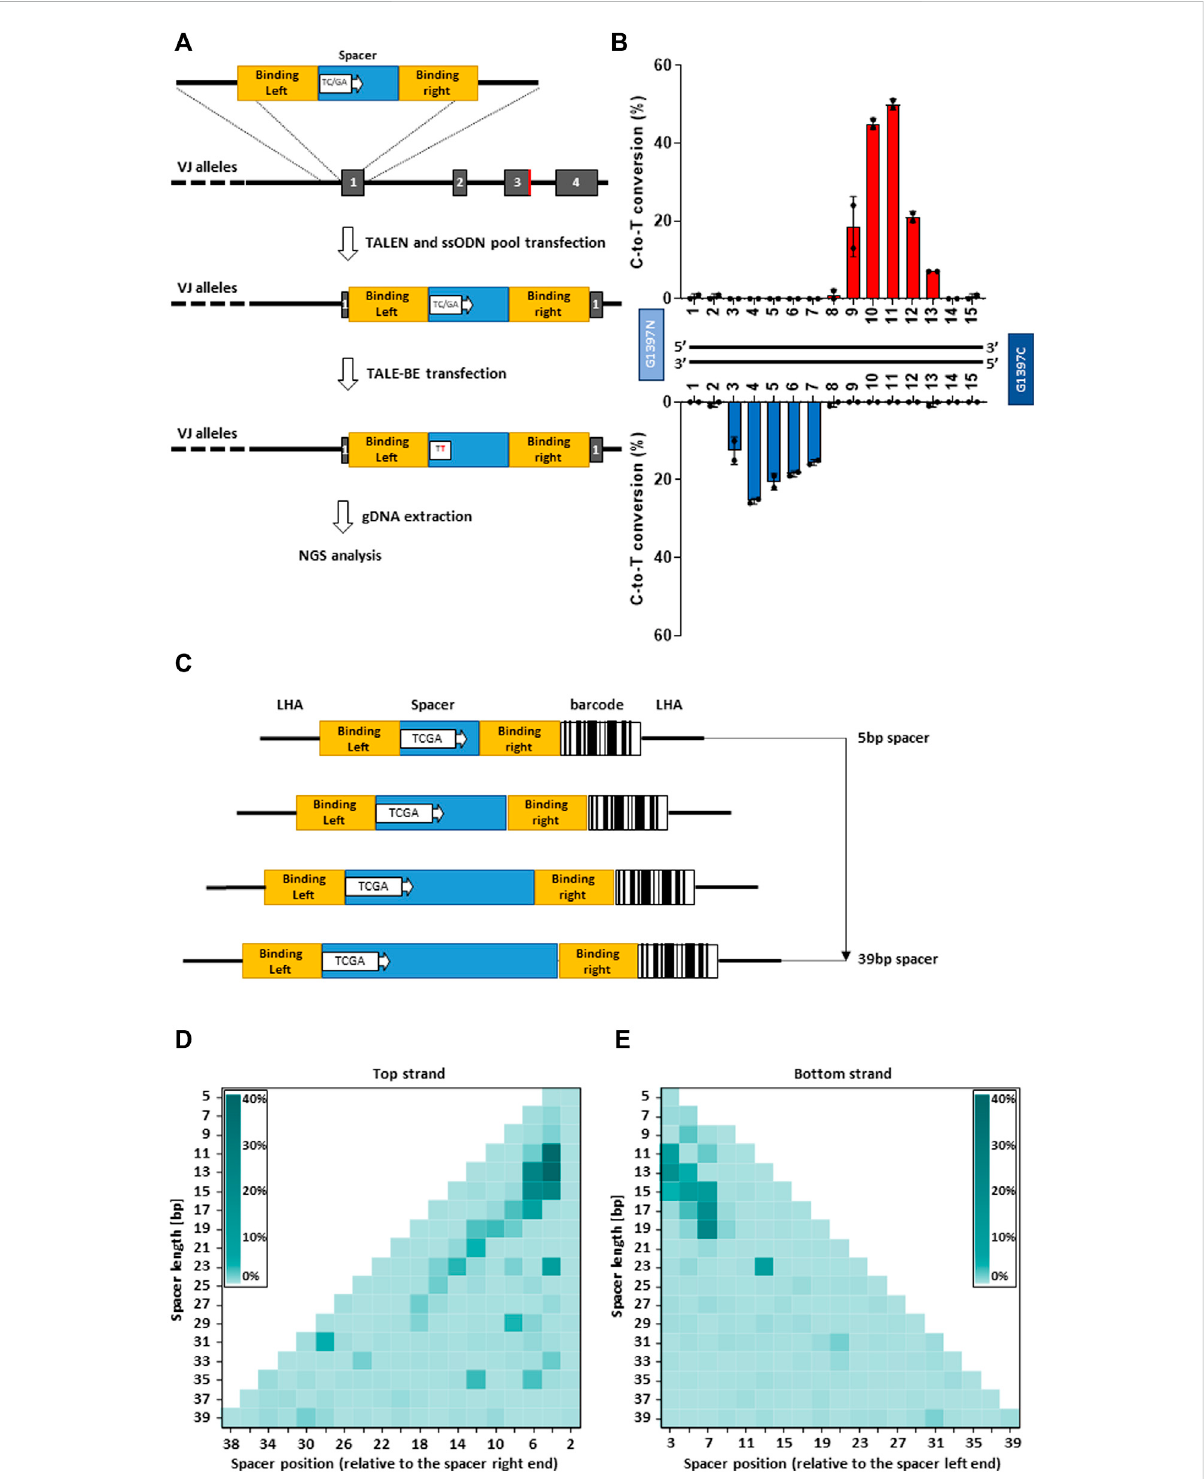
FIGURE 2 (A) . Scheme of the strategy to generate arti fi cial base editor target sites. In a fi rst step a pool of ssODN encoding various base editor spacer sequences is inserted into TRAC locus. In a second step the TALE-BE is transfected. Two days post transfection the genomic DNA is collected, and theinserted sequenceisanalyzed byNGS. (B) .Mean C-to-Tconversion frequenciesofthetarget Cs(top)orGs(bottom) atdifferentpositionswithin the15 bpTALE-BEspacer. (C) .SchematicrepresentationofthessODNpoolcollectionwithspacerlengthrangingfrom5to39 bp. (D) .heatmap of C-to-T conversion when the TC was present on the top strand in function of the spacer length. (E) . heatmap of C-to-T conversion when the TC was present on the bottom strand in function of the spacer length. For all panels: N = 2, independent T-cells